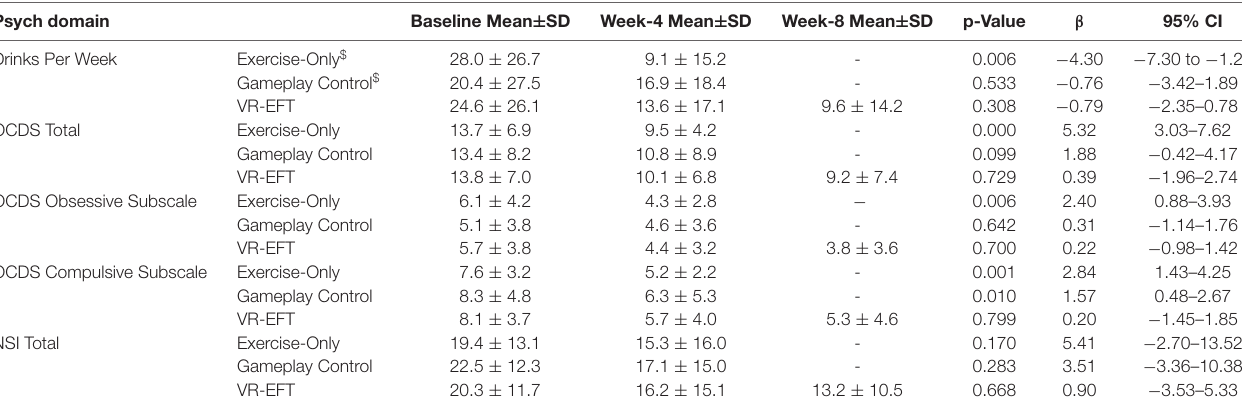
TABLE 3 | Exploratory outcome: within group effects of alcohol use, craving, and postconcussive symptoms. Psych